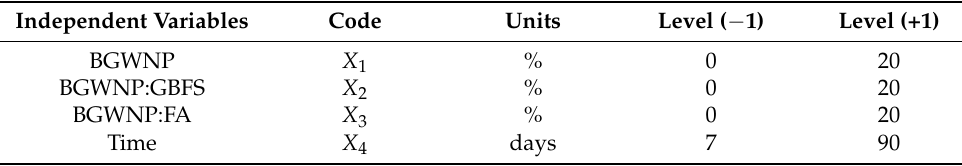
Table 2. Max. and min. values of the independent